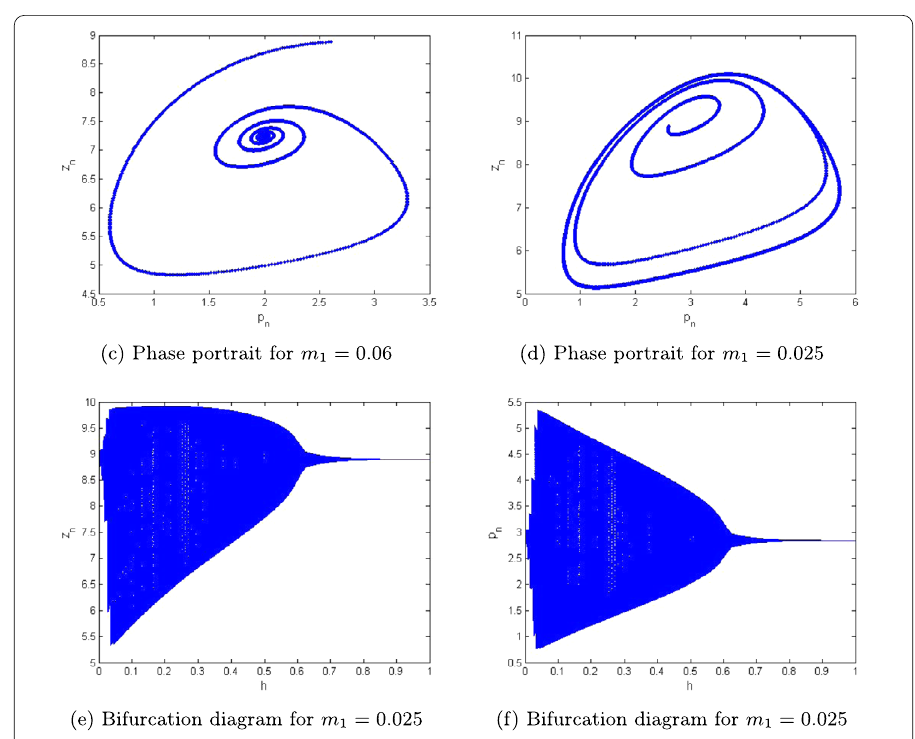
Figure 6 Bifurcation diagrams and phase portraits for system (1.5) for a = 2.1, q 1 = 0.09, q 2 = 0.3, r = 1.5, c = 0.14, k = 100, β = 0.5, α = 0.69, δ = 0.001, ρ = 0.1, m 2 = 0.021, and h =